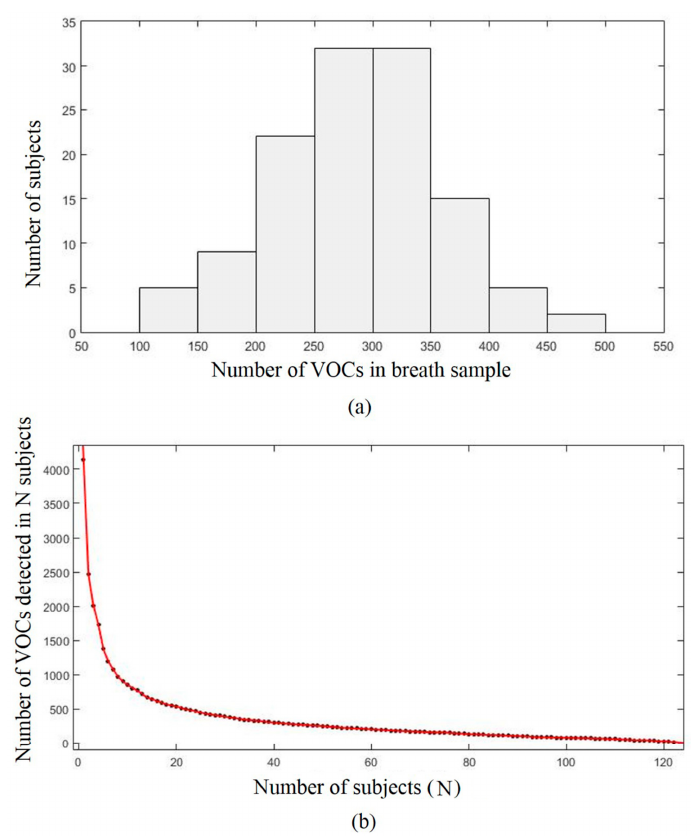
Figure 2. ( a ) The distribution of the number of volatile organic compounds (VOCs) in breath samples; ( b ) The number of VOCs in each subject. The subjects are ranked from the highest to the lowest number of detected VOCs. Overall, 4138 different VOCs were observed in the sample at least once. Only 17 VOCs were observed in all 122 subjects.